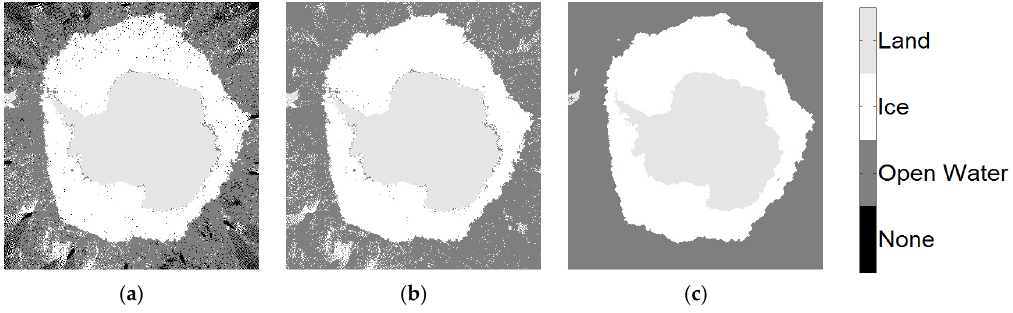
Figure 4. The gray images of Antarctic sea ice in 20 September 2013 through discrete steps (its central area is land): ( a ) FLDA discrimination with some portions of no observation and invalid parameters (black pixels); ( b ) black portion (in (a)) elimination dependent on the previous day’s HY-2A/SCAT data; ( c ) misclassification reduction by region growing and dilation/erosion techniques.